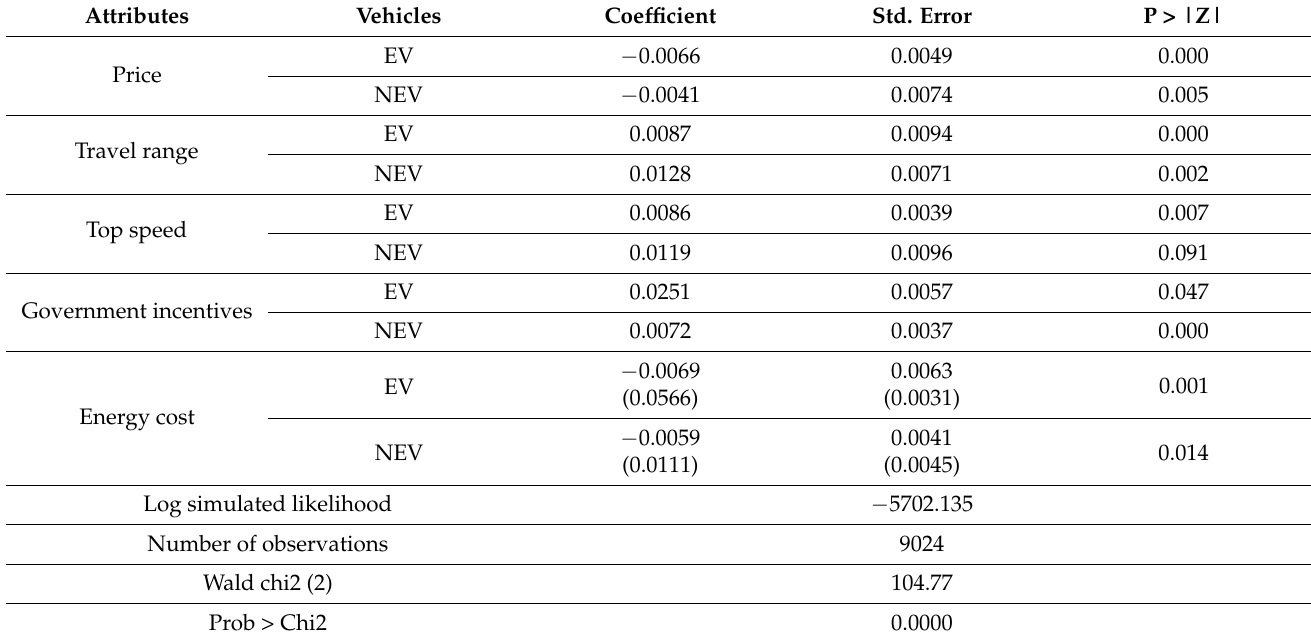
Table 8. Customers’ choice estimation